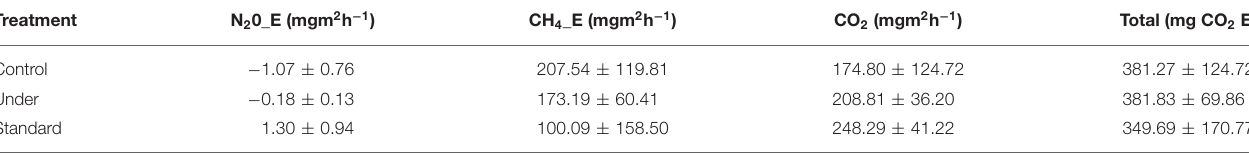
TABLE 3 | Total effect of the greenhouse gases summed up in mg CO 2 Equation.